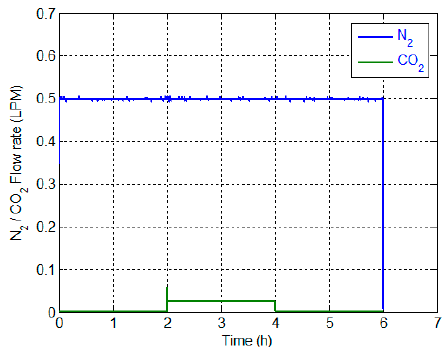
Figure 4. Flow rates of nitrogen and carbon dioxide during the experiment comprising consecutive purging, adsorption, and desorption steps.